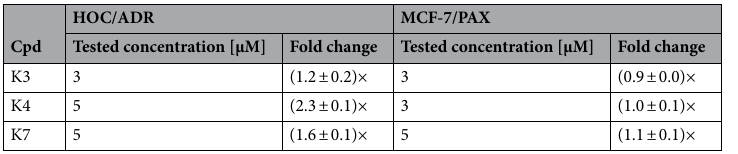
Table 8. Sensitization of resistant 3D ovarian (HOC/ADR) and breast (MCF-7/PAX) cancer spheroids by selected selenoesters. Data are expressed as the average sensitization rate (fold change) of four repetitions with standard error of the mean (SEM). Fold change was determined as the ratio of Adriamycin/paclitaxel IC 50 and Adriamycin/paclitaxel + selenoesters IC 50